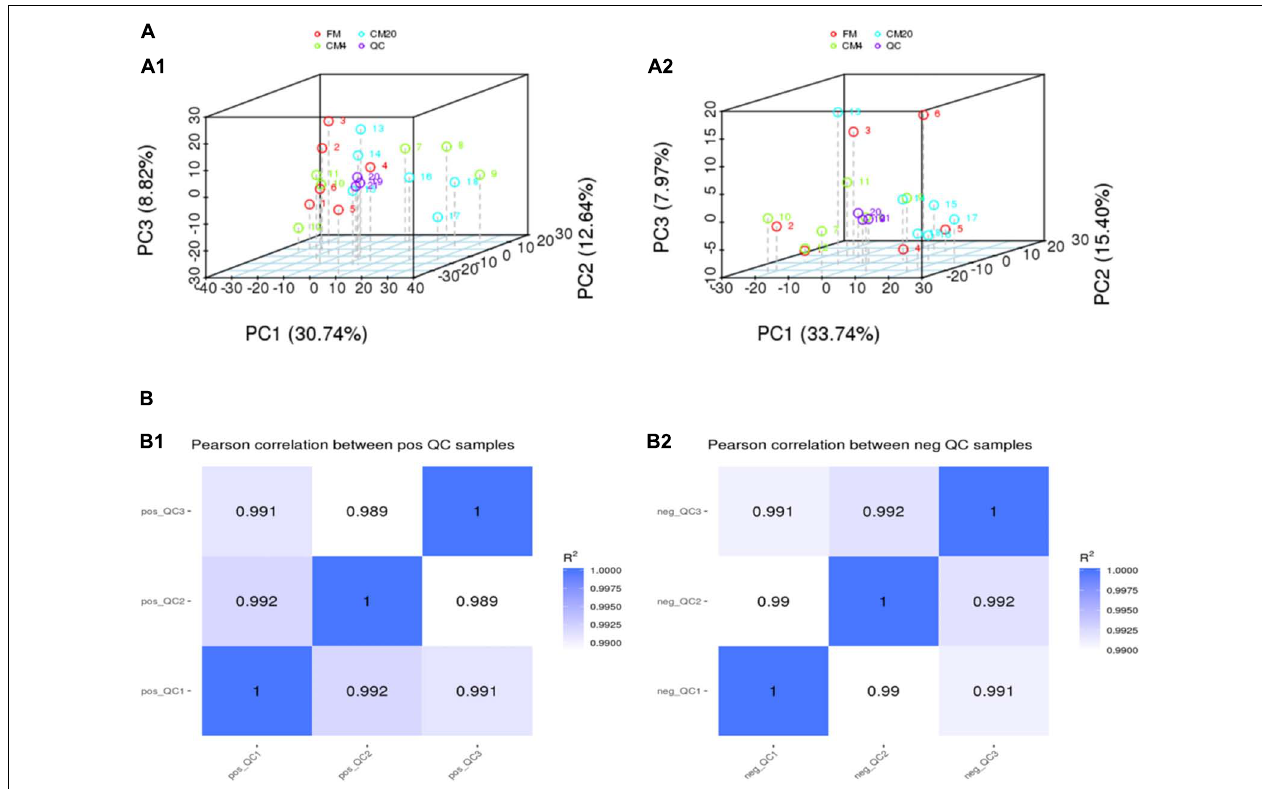
FIGURE 4 | (A) The results of the total sample PCA score plots from UPLC-MS spectra of the distal intestinal tissue in the positive (A1) and negative (A2) modes. Abscissa PC1 and ordinate PC2 represent the scores of the first and second principal components. Scattered dots in different colours represent samples from different experimental groups as illustrated in Figure 3 . QC represents the quality control group. (B) The QC samples of the distal intestinal contents’ correlation in the positive (B1) and negative (B2) modes. The abscissa is log10 (Peak. Area + 1), the ordinate (Peak. Area + 1), and the R 2 is the square of the Pearson correlation coefficient. n = 6.